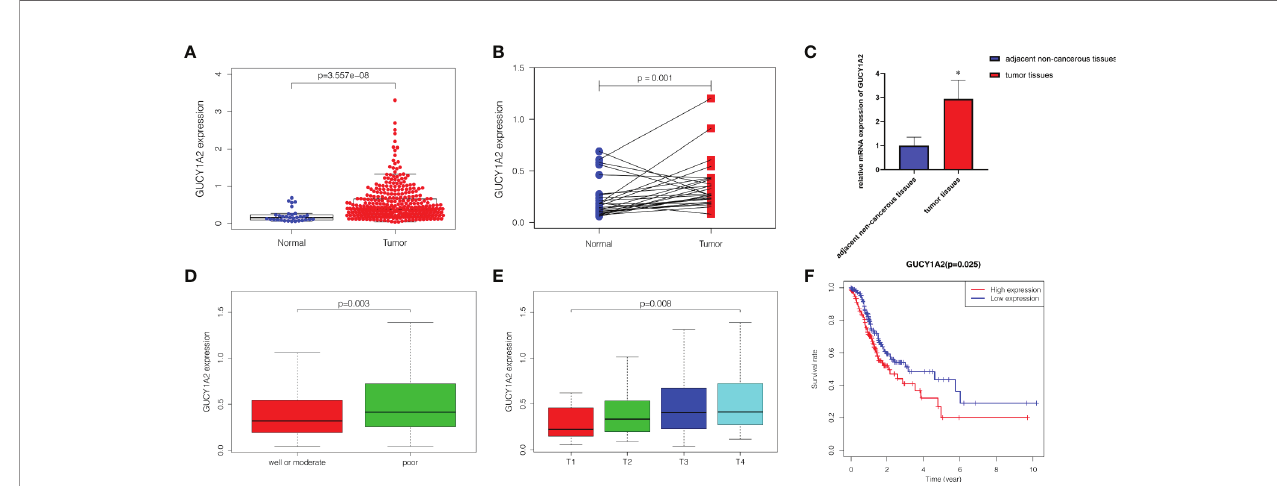
FIGURE 1 | The expression of GUCY1A2 and its association with clinicopathological parameters and OS based on TCGA database. (A) GUCY1A2 expression was higher in GC tissues than in adjacent noncancerous tissues ( P < 0.001); (B) GUCY1A2 was expressed at higher levels in GC tissues compared to 27 paired adjacent noncancerous tissues ( P = 0. 001); (C) qRT-PCR analysis of GUCY1A2 expression in 51 pairs of GC and adjacent noncancerous tissue samples ( P < 0.001); (D) Correlation between GUCY1A2 expression and histological grade ( P = 0.003); (E) Correlation between GUCY1A2 expression and T stage ( P = 0.008); (F) Kaplan- Meier curve of the relationship between GUCY1A2 expression and OS of GC patients ( P = 0.025). OS, overall survival; TCGA, The Cancer Genome Atlas; GC, gastric cancer; qRT-PCR, quantitative real-time polymerase chain reaction. * P <